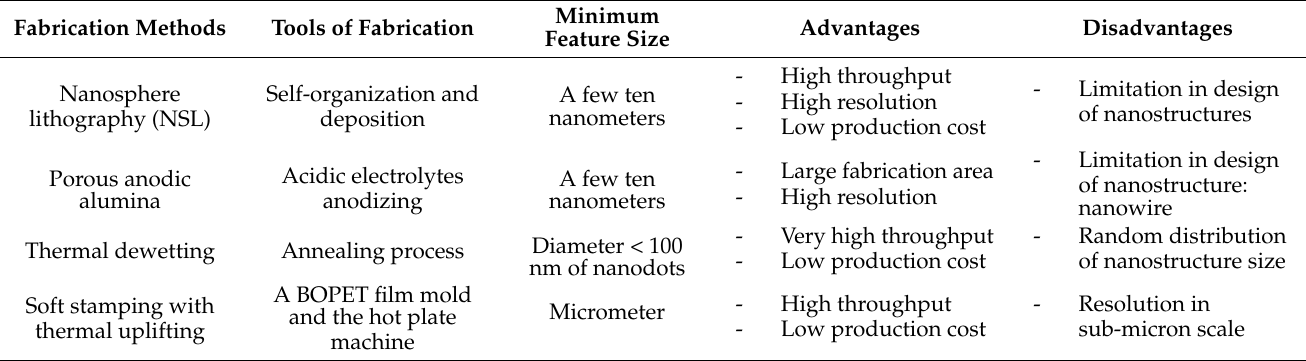
Table 1. The comparison of the micro/nanofabrication